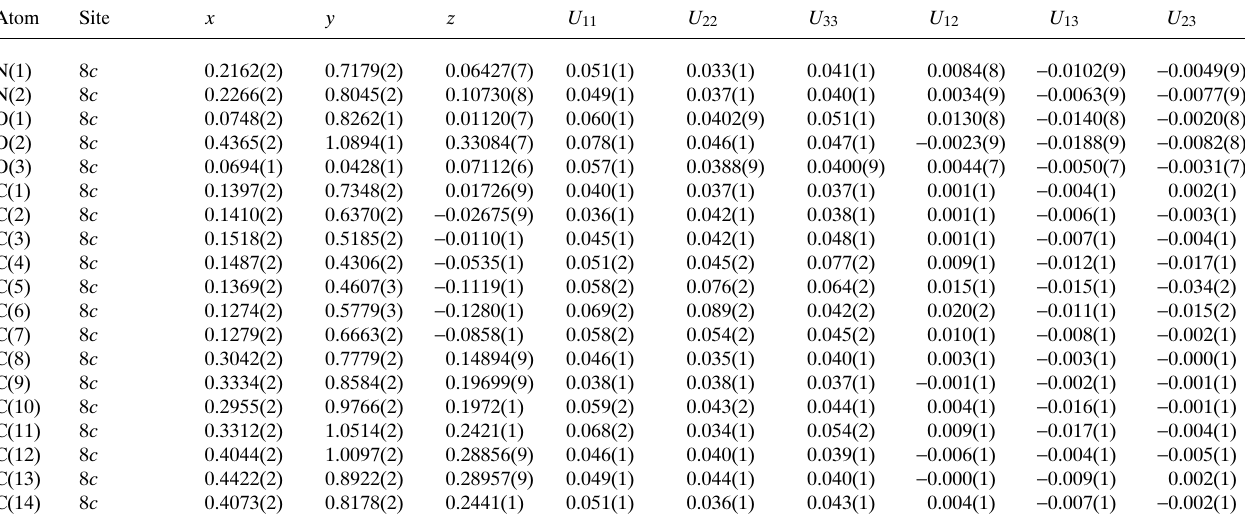
Table 3. Atomic coordinates and displacement parameters (in Å 2 )